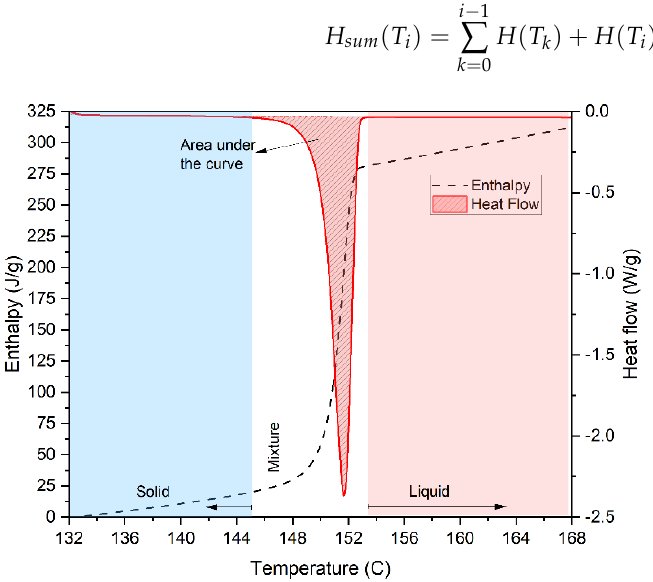
Figure 11. Heat flow and enthalpy plot of adipic acid as a function of temperature (personal data).